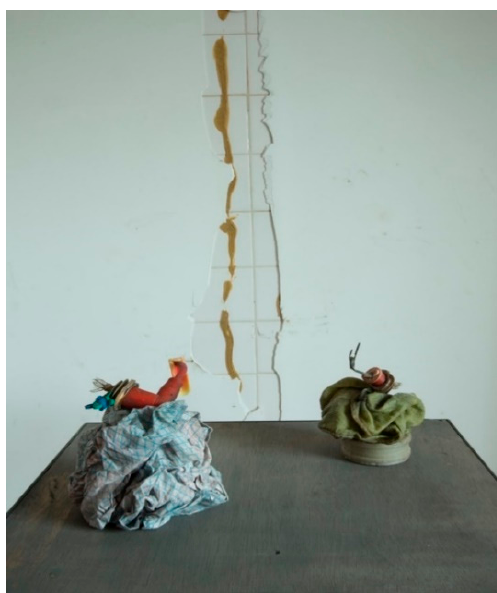
Figure 14. Matthias. 2016. Anatomical Cameo I and II , featured in S-O-T Body Repairs exhibition.